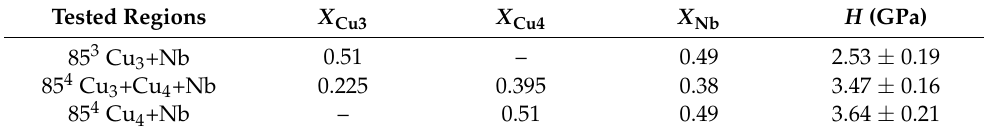
Table 2. Volume fraction and nanohardness of the composite regions in 85 3 and 85 4 Cu-Nb wires. Tested Regions X Cu3 X Cu4 X Nb